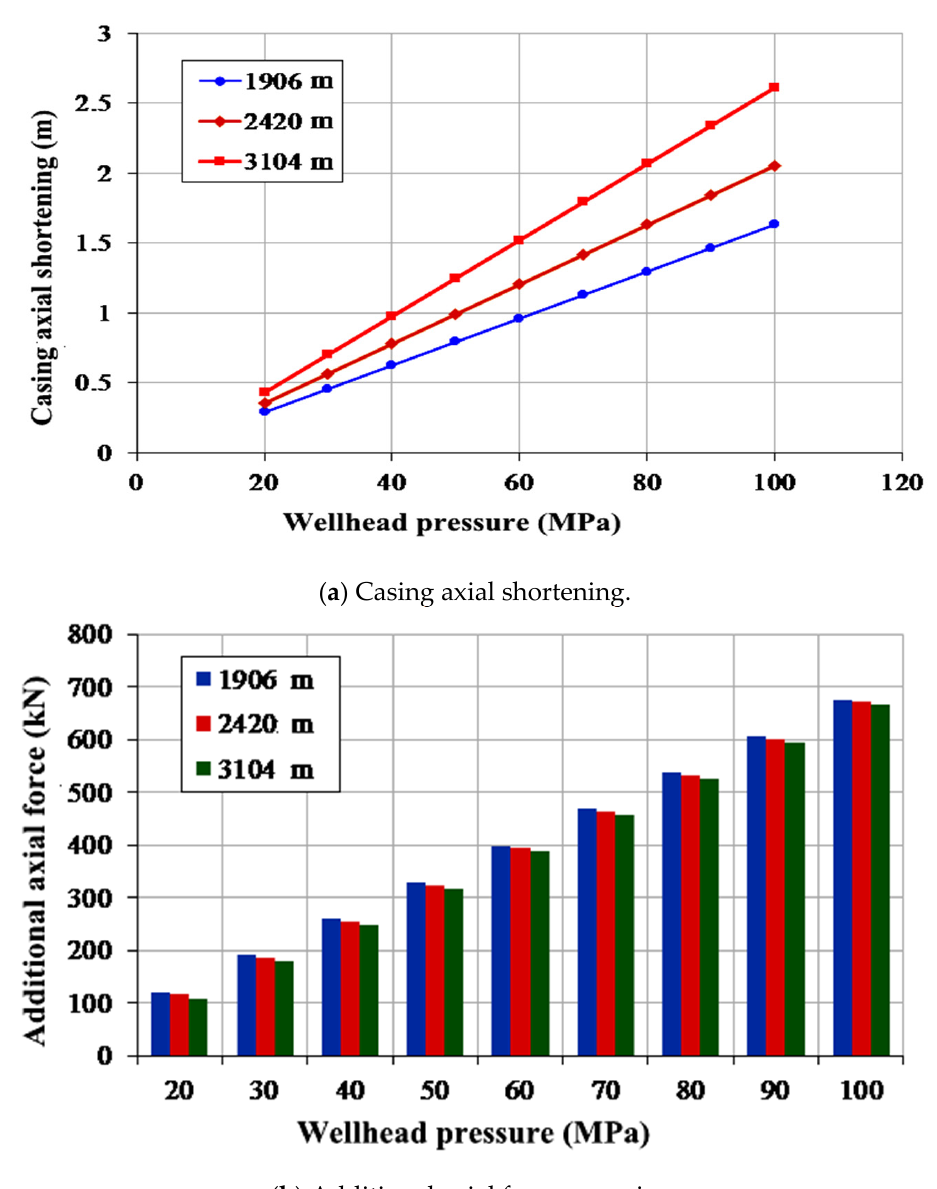
Figure 2. Change of casing axial length and additional axial force under different sealing section length.